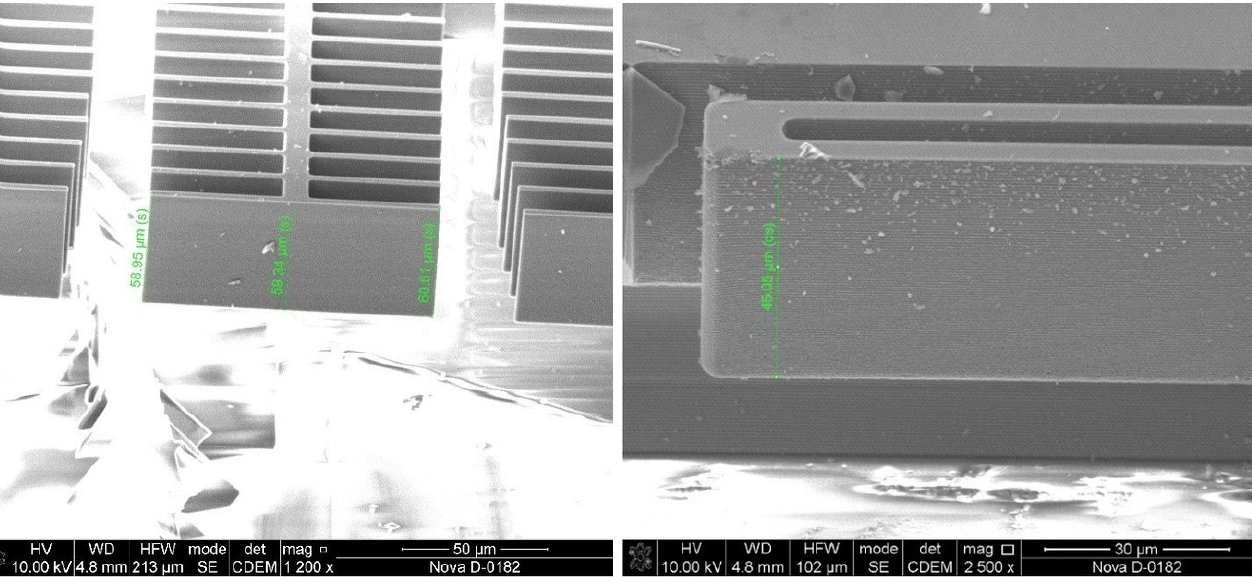
Figure 30. Measuring the height of the instrument layer by